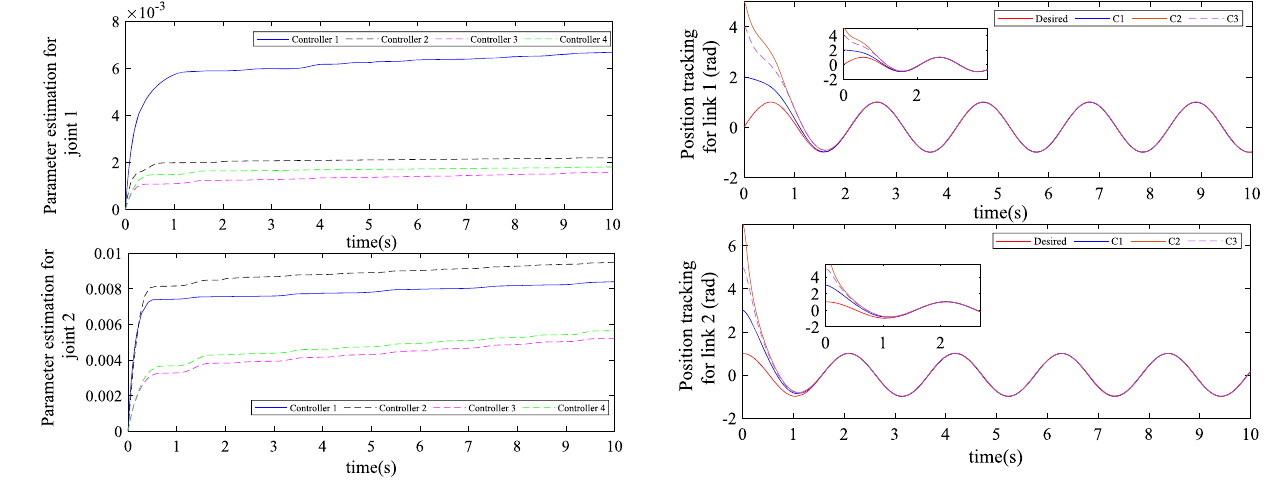
Fig. 7 Comparison of trajectory tracking with different initial